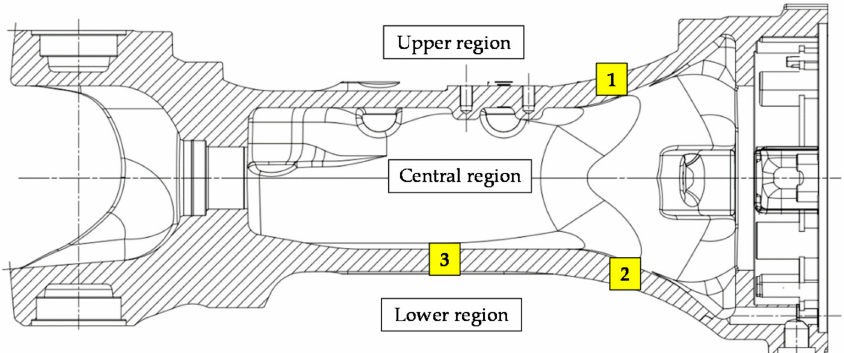
Figure 2. Regions of the axle where metallographic analyses and Brinell hardness measurements have been performed. Table 1. Size and shape of graphite nodules and matrix composition in the regions of the axle defined in Figure 2 according to ISO 945-1:2018 [32].